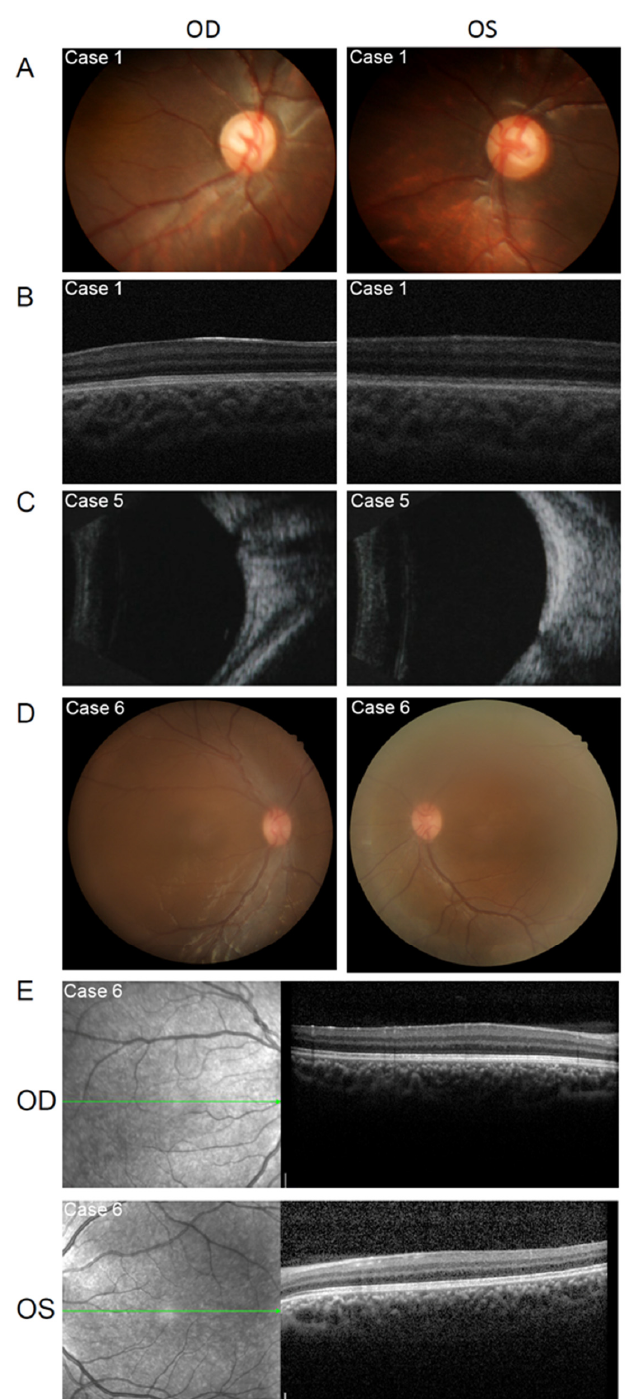
Figure 4. Ocular features of the patients with WAGR syndrome. ( A ). Fundus photograph of case 1 showing increased cup-to-disc ratio in both eyes. ( B ). OCT images of case 1 showing macular hypoplasia in both eyes. ( C ). B-scan images of case 5 showing increased cup-to-disc ratio in both eyes. ( D ). Fundus photograph of case 6 showing macular hypoplasia of both eyes. ( E ). OCT images of case 6 showing macular hypoplasia in both eyes.